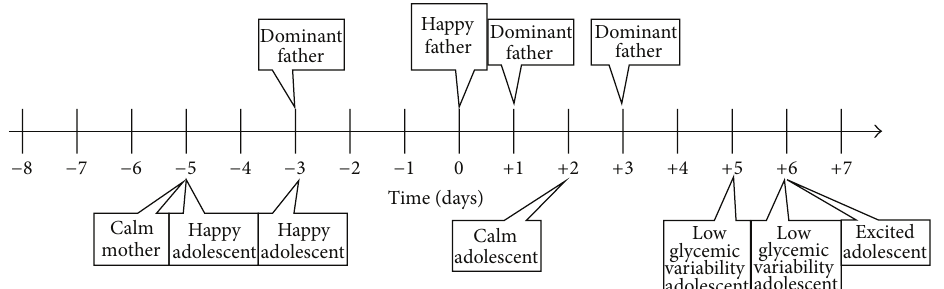
Figure 5: Timeline displaying effects correlating with affective valence in the father of the adolescent index patient. The graph depicts a psychosomatic cycle in which various emotional states of all involved family members influence affective valence (pleasure) of the father to the adolescent patient and vice